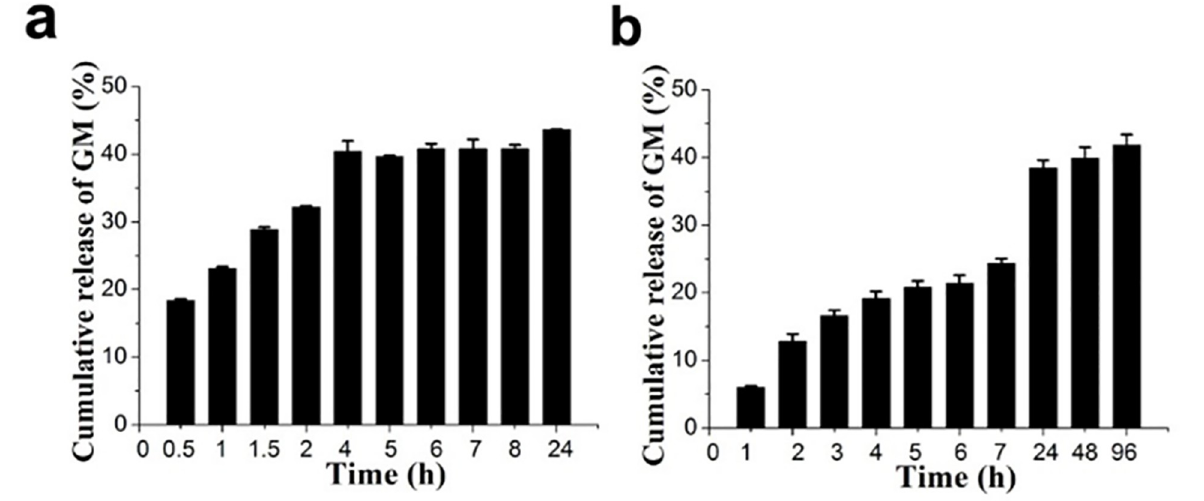
Fig 4. Cumulative release curves of (a) CMs(GM) and (b) CMs(GM)- β -TCP/gelatin composite scaffolds. (CMs: Chitosan microspheres; GM: Gentamycin; β -TCP: β -tricalcium phosphate).